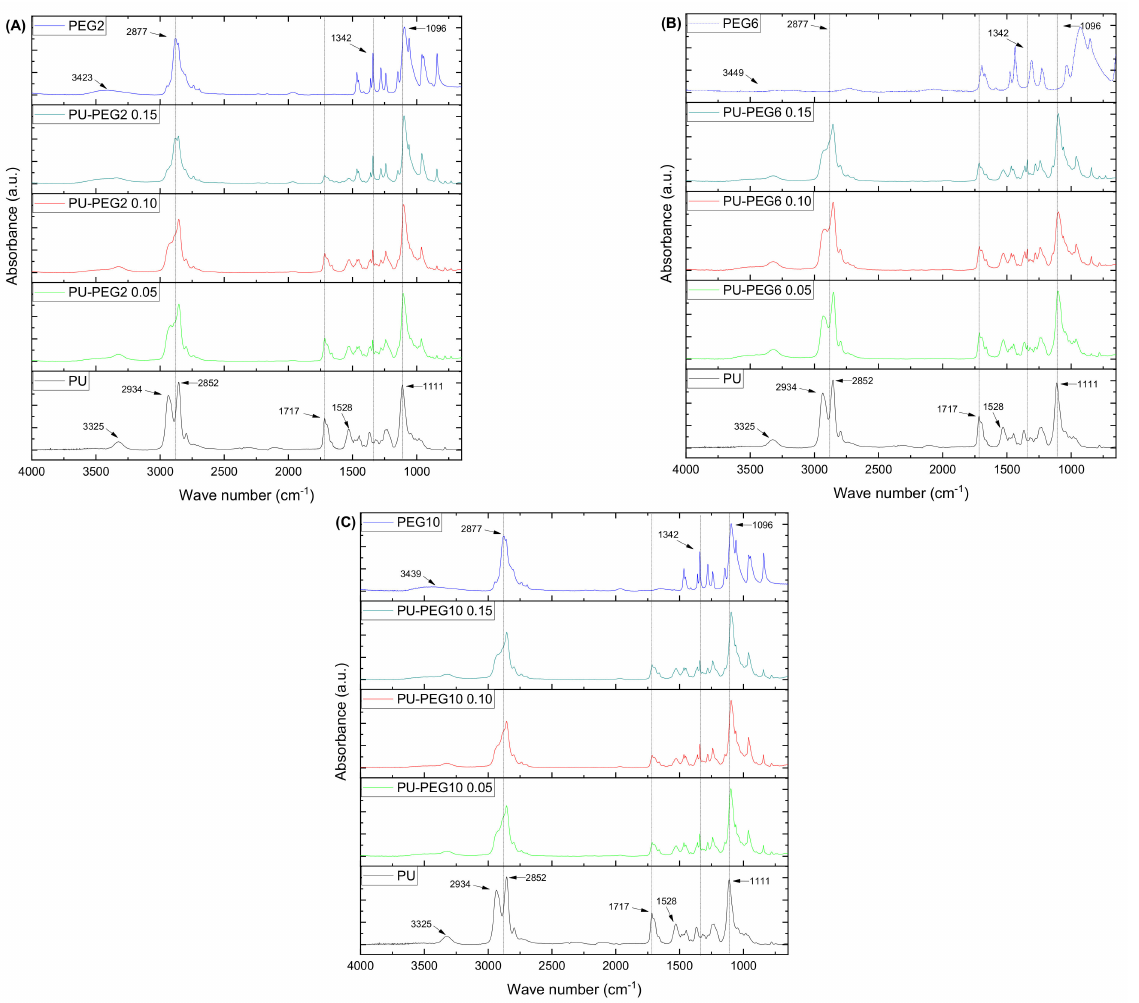
Figure 2. FTIR-ATR spectra of the PU substrata and PEG. As the grafting density is increased, the spectra of the substrata look more similar to PEG spectra, indicating that there is a higher amount of PEG chains present. ( A ): PEG 2 kDa; ( B ) PEG 6 kDa; ( C ) PEG 10